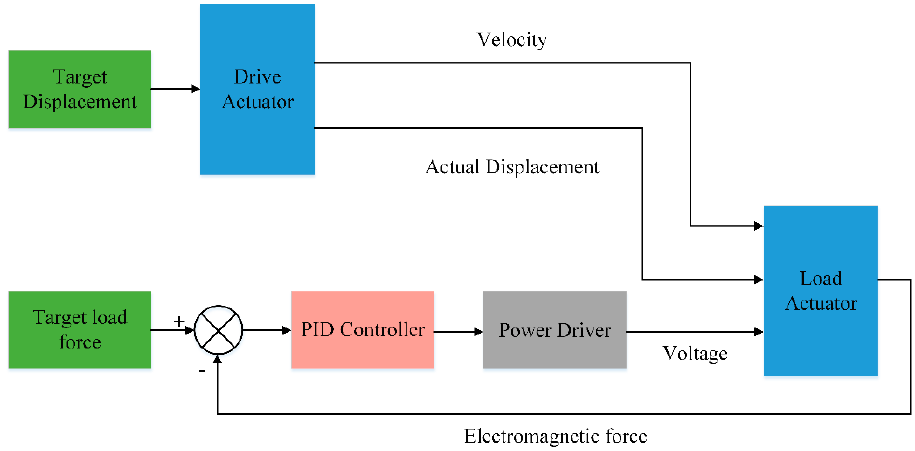
Figure 10. Simulation model of the electric load simulator.